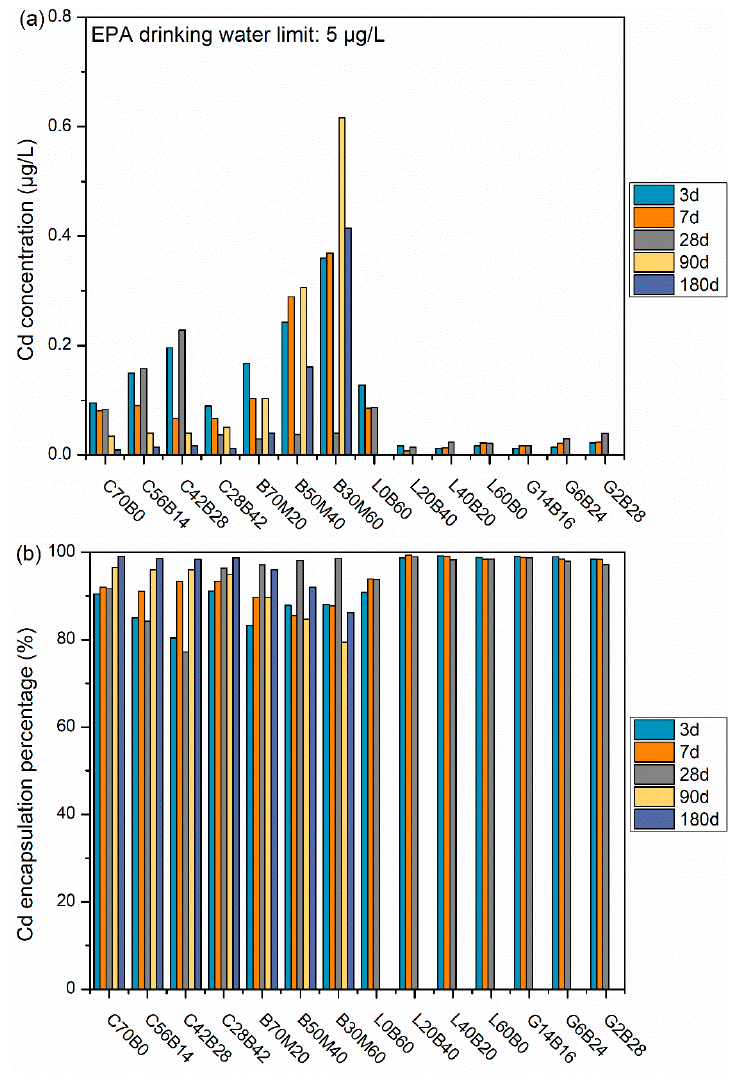
Figure 10. The ( a ) Cd concentration and ( b ) encapsulation percentage for the leachate in all groups at all ages.